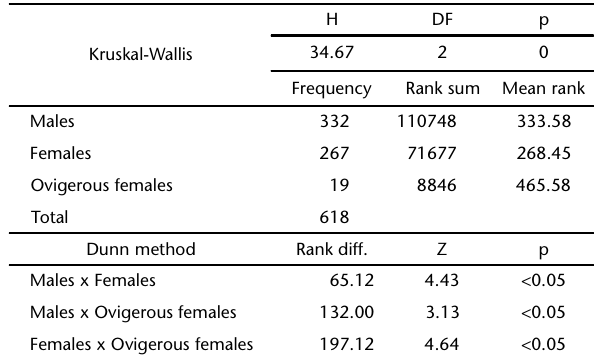
Table IV. Kruskal-Wallis test results followed by Dunn test for size of males, females and ovigerous females of Callinectes ornatus .